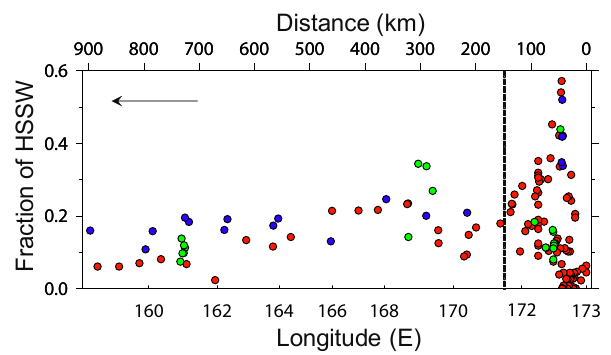
Fig. 7. Distribution of fraction of the HSSW within 100m from bottom along flow path of the RSBW estimated by OMP analy- sis. Blue circles are from occupations in the 1970s, green circles are from 1990s and red circles are from 2000s. An arrow indicates downstream direction of RSBW and vertical dashed line separates modification path of MSW and flow path of RSBW. See text for definition of